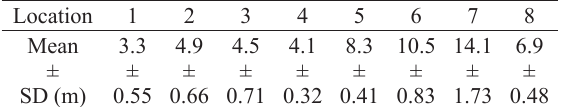
Mean depth (m) and standard deviation (SD) of each sample location in the São Vicente Estuary (1-4) and the Santos Bay (5-8), São Paulo, Location